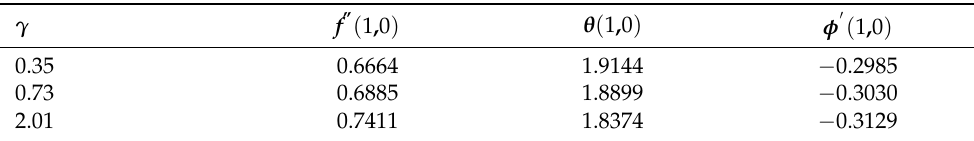
Table 3. Solutions of f (cid:48)(cid:48) ( 1,0 ) , θ ( 1,0 ) , and φ (cid:48) ( 1,0 ) for various values of γ at n = 1.0, Sc = 1.0, N = 1.0, f w = 0.0, κ = 0.5, and Nt =